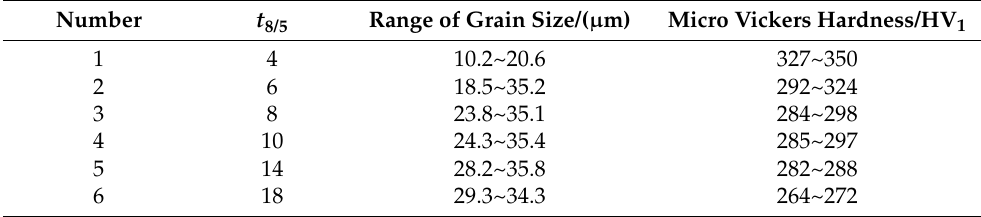
Table 4. Results of the grain size distribution and hardness at a peak temperature of 1250 ◦ C.